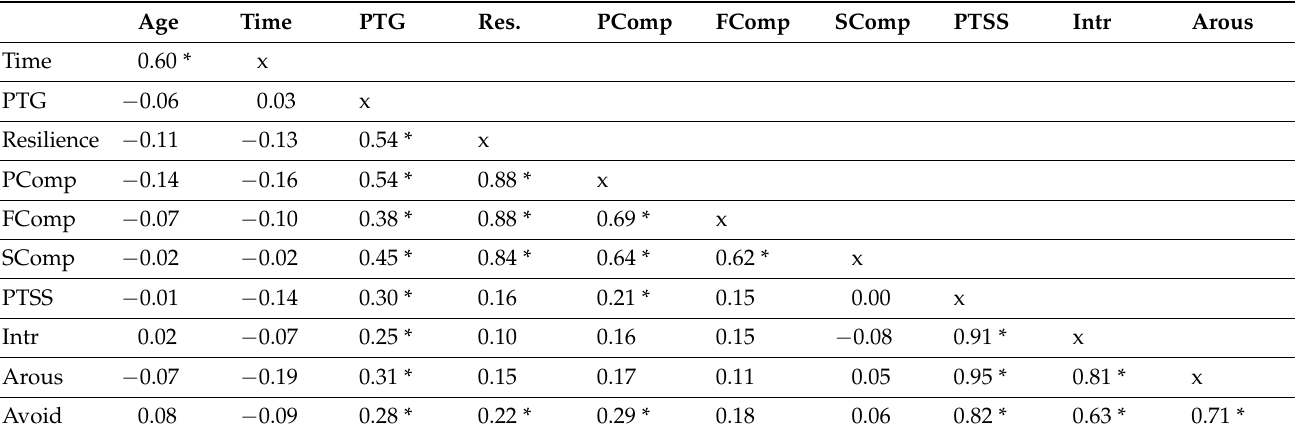
Table 3. Correlation